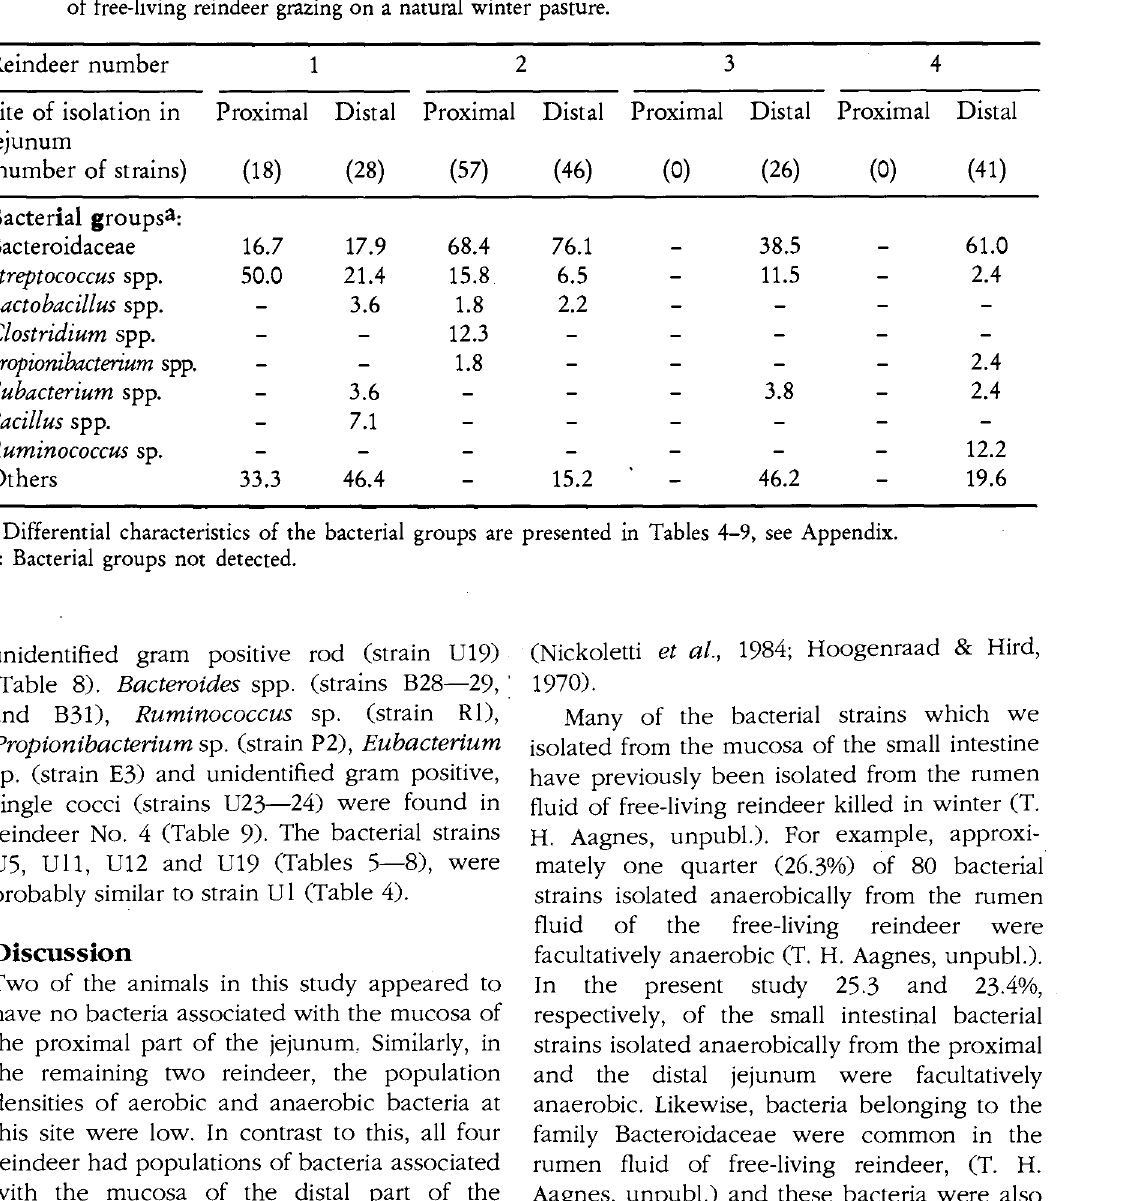
Bacterial groups 3 : Streptococcus spp. spp. Propionibacterium spp. Eubacterium spp. Bacillus spp. Others a Differential characteristics of the bacterial groups are presented in Tables 4-9, see Appendix.